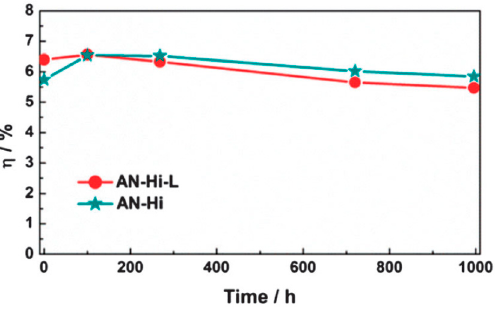
Figure 2. Efficiency variation over time for DSCs based on the electrolytes AN-Hi-L and AN-Hi during the stability test. Adapted and reprinted with permission from [52].